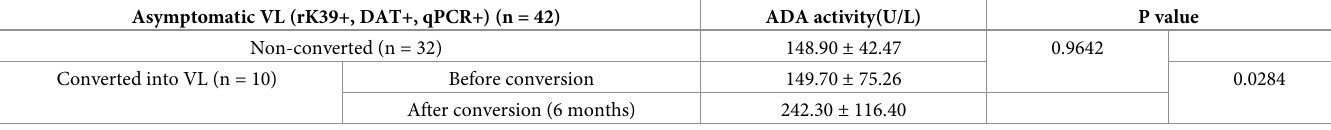
Table 3. Serum ADA activity in asymptomatic VL and after conversion into VL (Serum ADA activity of asymptomatic VL (n = 10) and after conversion into active VL (n = 10)). Asymptomatic VL (rK39+, DAT+, qPCR+) (n = 42)